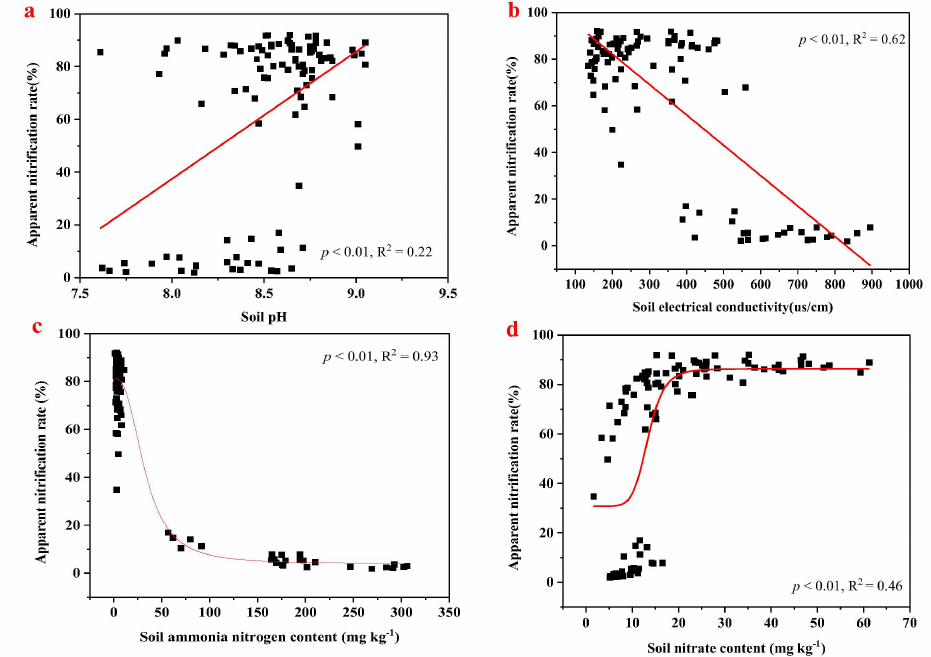
Figure 4. Person correlation analyses between the soil’s basial characters and apparent nitrification rate. ( a ) The correlation of apparent nitrification rate with soil pH; ( b ) The correlation of apparent nitrification rate with soil electrical conductivity; ( c ) The correlation of apparent nitrification rate with soil ammonia nitrogen; ( d ) The correlation of apparent nitrification rate with soil nitrate